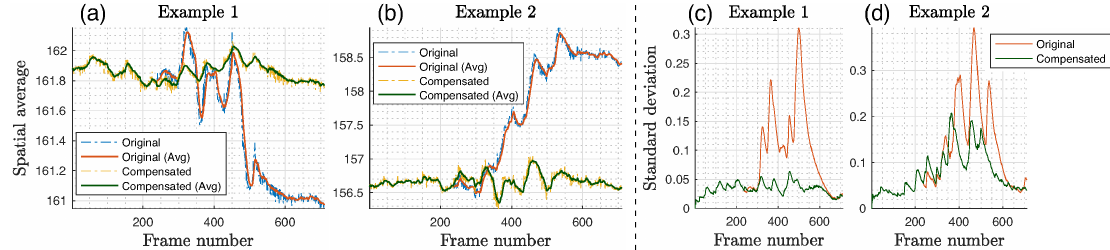
Figure 9. ( a , b ) Original (uncompensated) spatially averaged signals extracted from the silicone palm plotted with a motion compensated using Intensity-Based Method 1 to assess the effect of image registration in the time domain. Signals were passed through a simple 25-tap moving average filter (for illustration purposes) to suppress noise and show signal contours better. ( c , d ) Standard deviation ( σ ¯ I ) of the spatially averaged signal from an ROI was used as a metric to assess motion artifact